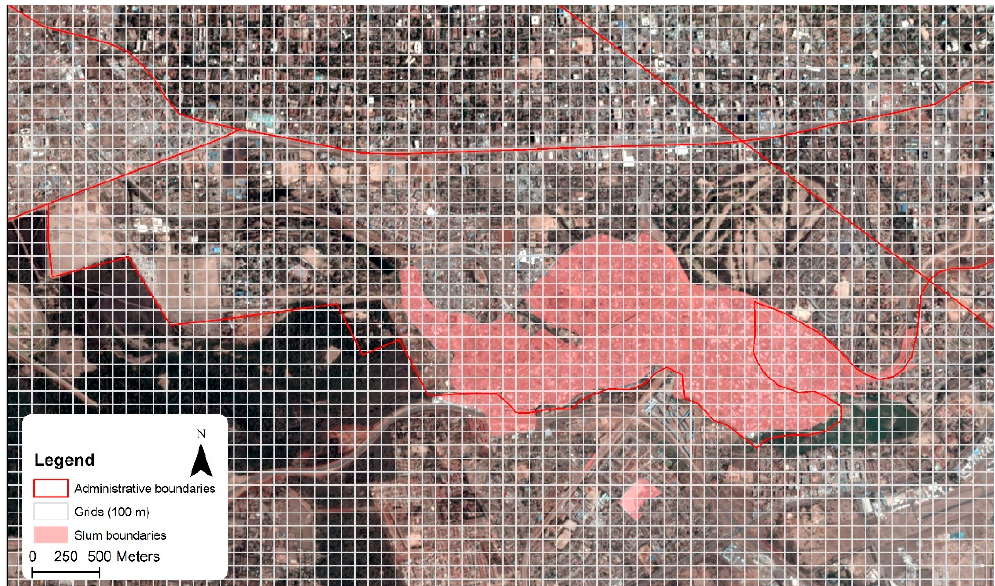
Figure 2. Gridded mapping frame to aggregate deprived areas, the example is showing Kibera slum in Nairobi (displayed on top of a PlanetScope image).